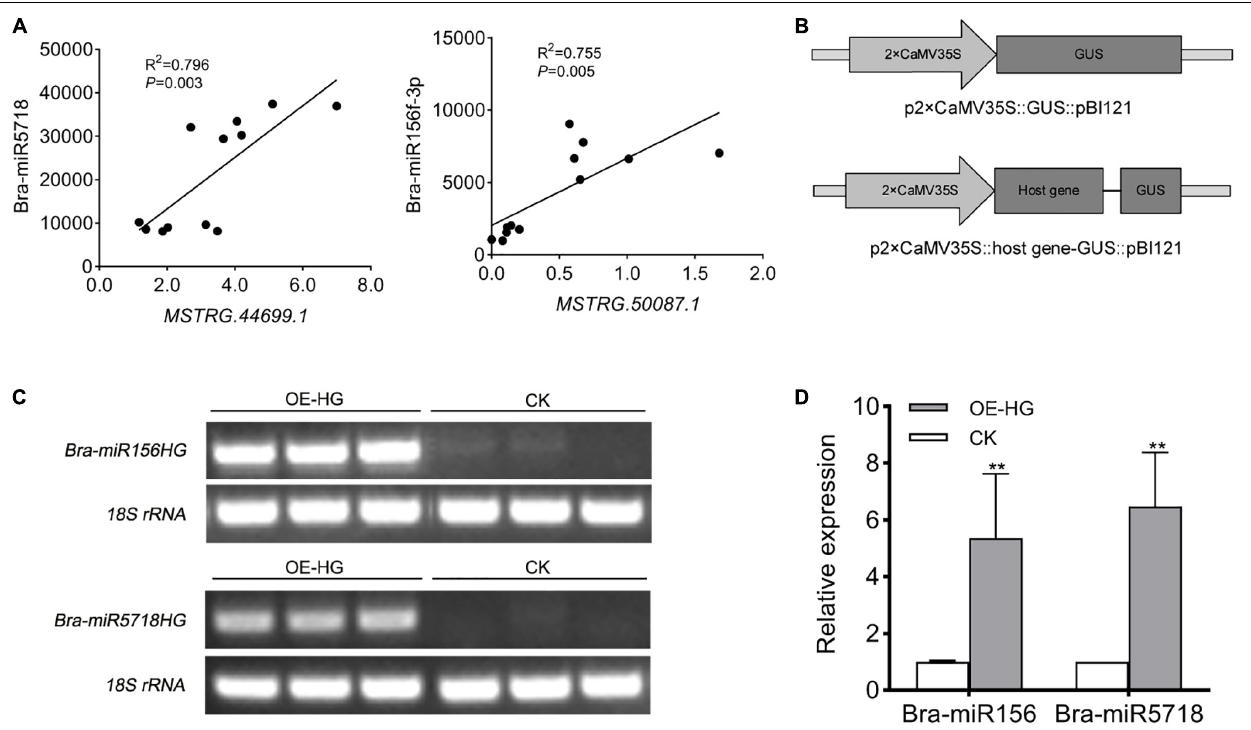
FIGURE 6 | LncRNAs, bra-miR156HG and bra-miR5718HG , worked as host genes for miR156 and miR5718 in Brassica campestris . (A) Expression correlation between bra-miR5718HG and bra-miR156HG and the corresponding miRNAs. (B) Structure of expression vectors used for transient agroinfiltration assay. (C) Semi reverse transcriptase PCR verifying the overexpression of lncRNAs in tobacco leaves. The lane of OE-HG represents samples containing corresponding lncRNA overexpression vectors. (D) Real-time quantitative PCR revealing the up-regulation of miR156 and miR5718. Data were presented as mean ± SD and the t -test was used for significance analysis. ** P < 0.01. Triplicate experiments were conducted. LncRNAs, long non-coding RNAs; miRNAs,